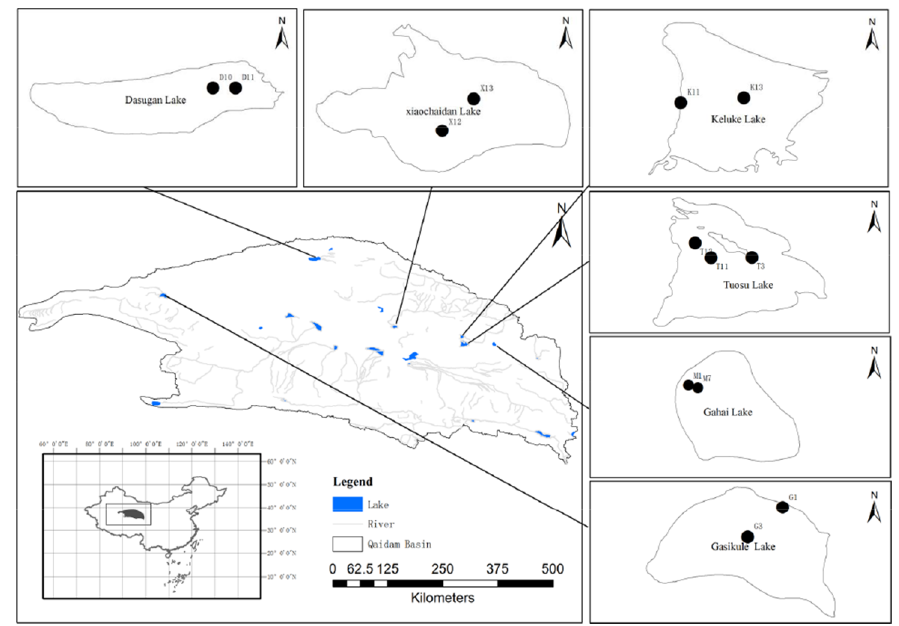
Figure 1. Locations of investigated lakes in Qaidam Basin. In Figure, K, T, D, M, X and G referred to Lake Keluke, Lake Tuosu, Lake Dasugan, Lake Gahai, Lake Xiaochaidan and Lake Gsikule, respectively.